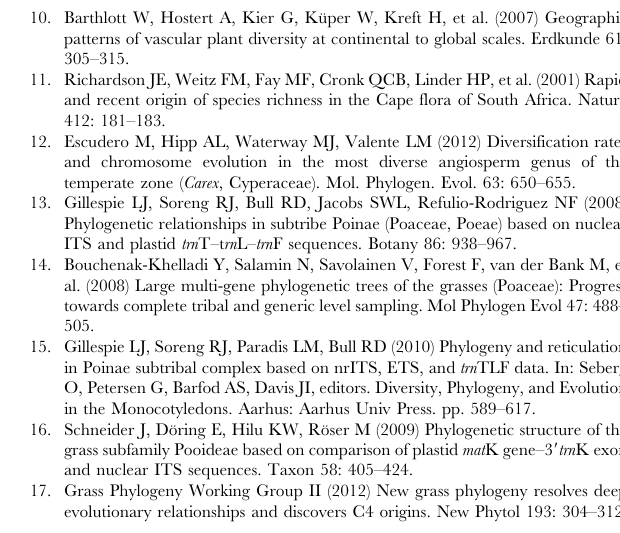
sources of the ITS sequences used in this